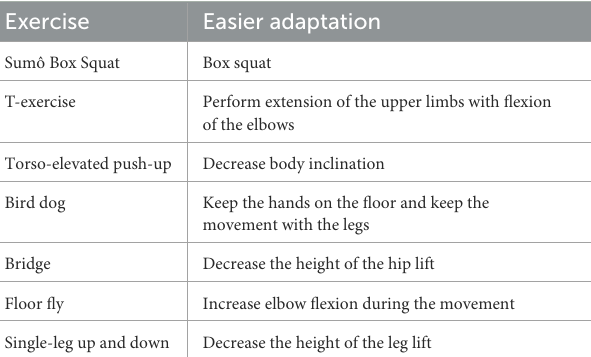
TABLE 4 Exercise